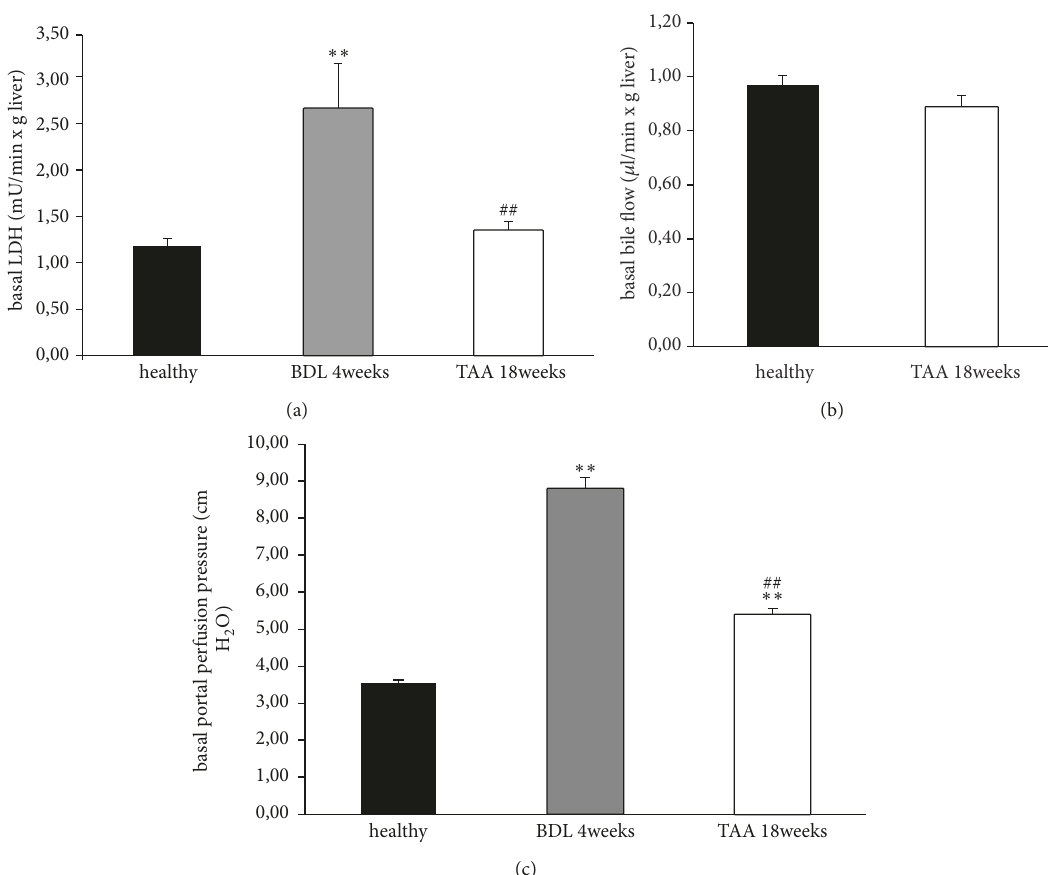
Figure 3: Basal values of lactate dehydrogenase, bile flow, and portal perfusion pressure in healthy, fibrotic, and cirrhotic livers . To induce liver fibrosis, bile duct ligation (BDL) was performed in male SD rats, and to induce liver cirrhosis, animals received thioacetamide (TAA) administered via drinking water. Healthy, fibrotic, and cirrhotic livers were perfused for 30 min. Lactate dehydrogenase (LDH; (a)) was measured in the perfusate, bile was collected to determine the bile flow (b), and the portal perfusion pressure (c) was monitored continuously. All data are expressed as the mean ± SEM. Significant values are specified as ∗∗ p < 0.01 (fibrotic/cirrhotic liver compared to healthy liver) and ## p < 0.01 (cirrhotic liver compared with fibrotic